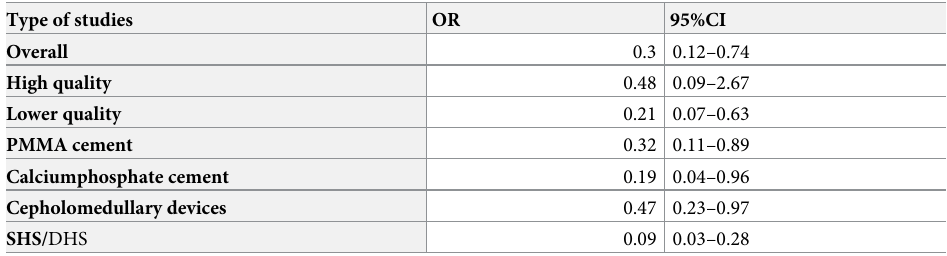
Table 2. Sensitivity